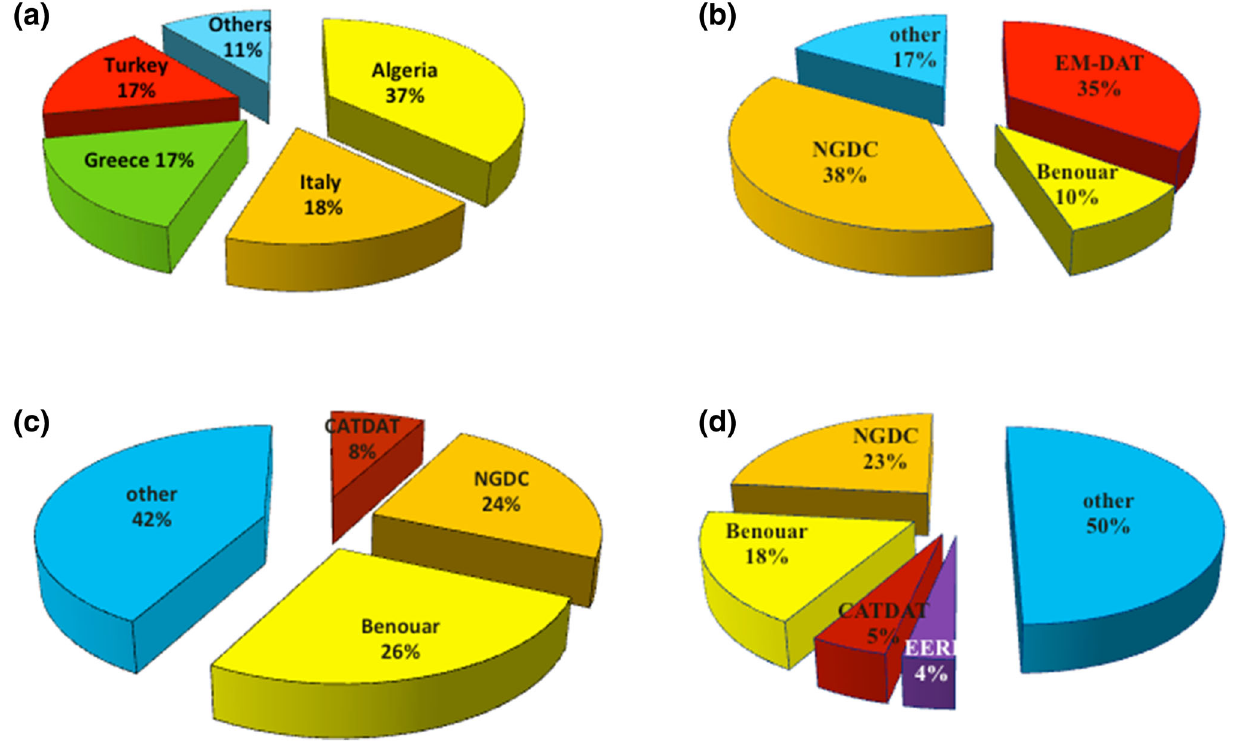
Fig. 2 Distribution of the earthquakes included in the present study: a by country in the Mediterranean region; b – d by associated socioeconomic losses used and data source, for economic losses ( b ), home loss ( c ), and number of damaged buildings ( d